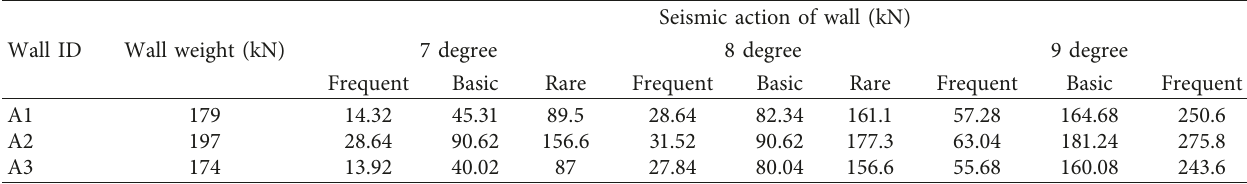
Table 10: Seismic shear force corresponding to seismic intensity (kN).